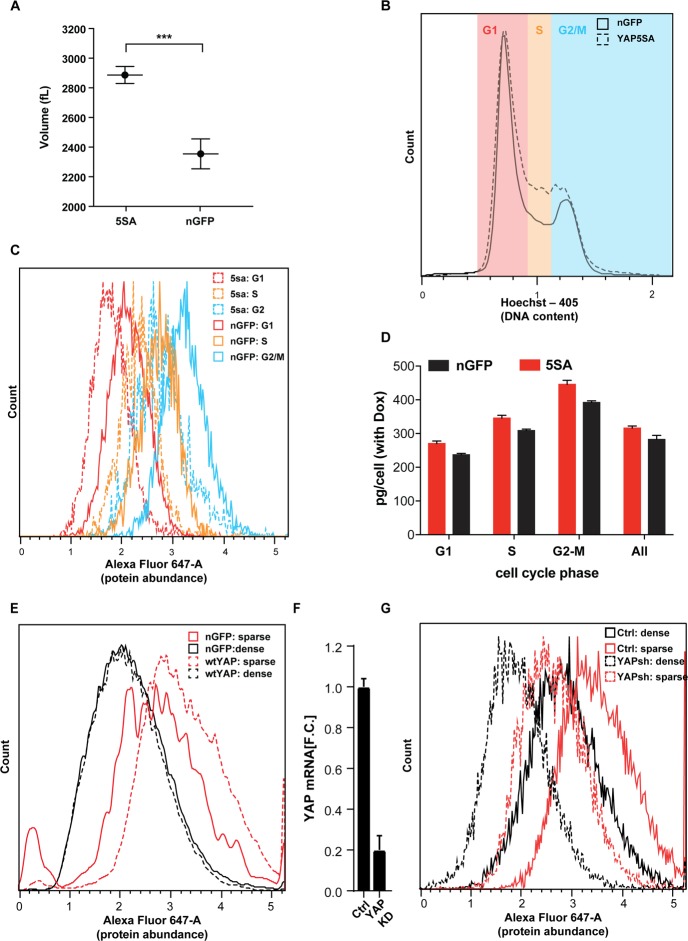
The effect of YAP5SA, YAPwt and YAPsh expression on cell size.(A) Average cell volume was measured in a population of YAP5SA and nGFP-expressing Flipin-TREX-293 cells maintained in Dox+ medium over several passages. Cells were seeded at ~50% confluence the night before the measurement in 10 ml medium, on 10 cm dishes. For the measurement cells were trypsinized and resuspended in Coulter measurement buffer. 5SA-expressing cells are ~25% larger than nGFP-expressing cells. (B) In low density cultures of FlipinTrex-293 cells, YAP5SA vs. nGFP expression leads to a higher fraction of cells in S and G2/M. Cell cycle analysis was done after cells were trypsinized and stained using Hoechst as a DNA dye and the SE-dye for protein. (C) Total protein content is higher in YAP5SA-expressing cells (5SA) vs nuclear GFP (nGFP) controls throughout the cell cycle. (D) We also used quantitative phase microscopy (QPM) to simultaneously determine average dry cell mass/cell and cell cycle phase in three different clones of Flipin-TREX-293 cells expressing YAP5SA vs nGFP. Cells were cultured on 10 cm dishes for 3 days in the presence of Dox before they were transferred to a Fibronectin-coated, glass-bottom 6-well plate at ~50,000 cells/well for the measurement. Each measurement is based on >4000 total of cells not in contact with other cells. Each cells was binned into its respective position in the cell cycle based on the Hoechst signal intensity. The figure depicts the mean ± S.D. of the three clones. (E) Protein concentration in a population HEK293 cells constitutively expressing wild-type(wt) YAP was compared to nGFP-expressing controls. The histogram represents the distribution of protein concentration as estimated by SE-dye labelled cells cultured at high or low density. A day before the measurement cells were cultured in 10 ml medium on 10 cm dishes at ~10×10^6 cells/dish (high density) or 2.5 × 10^6 cells/dish (low density). For the measurement, cells were simultaneously trypsinized, fixed, permeabilized and stained with the SE-647 dye, then measured on an LSRII. wtYAP overexpression increases cell size in low density cultures. (F, G) A similar experiment as described in E) was done on HEK293 cells in which YAP levels were reduced to ~80% by shRNA expression (YAPKD) vs. empty vector controls (Ctrl). YAPKDs are smaller than empty vector controls (Ctrl) in sparse and dense cultures.